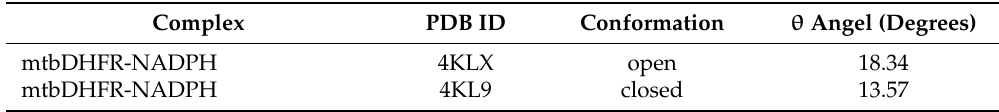
Table 2. The conformation type and the θ angle of 9 crystal structures of mtbDHFR. Complex PDB ID Conformation mtbDHFR-NADPH 4KLX